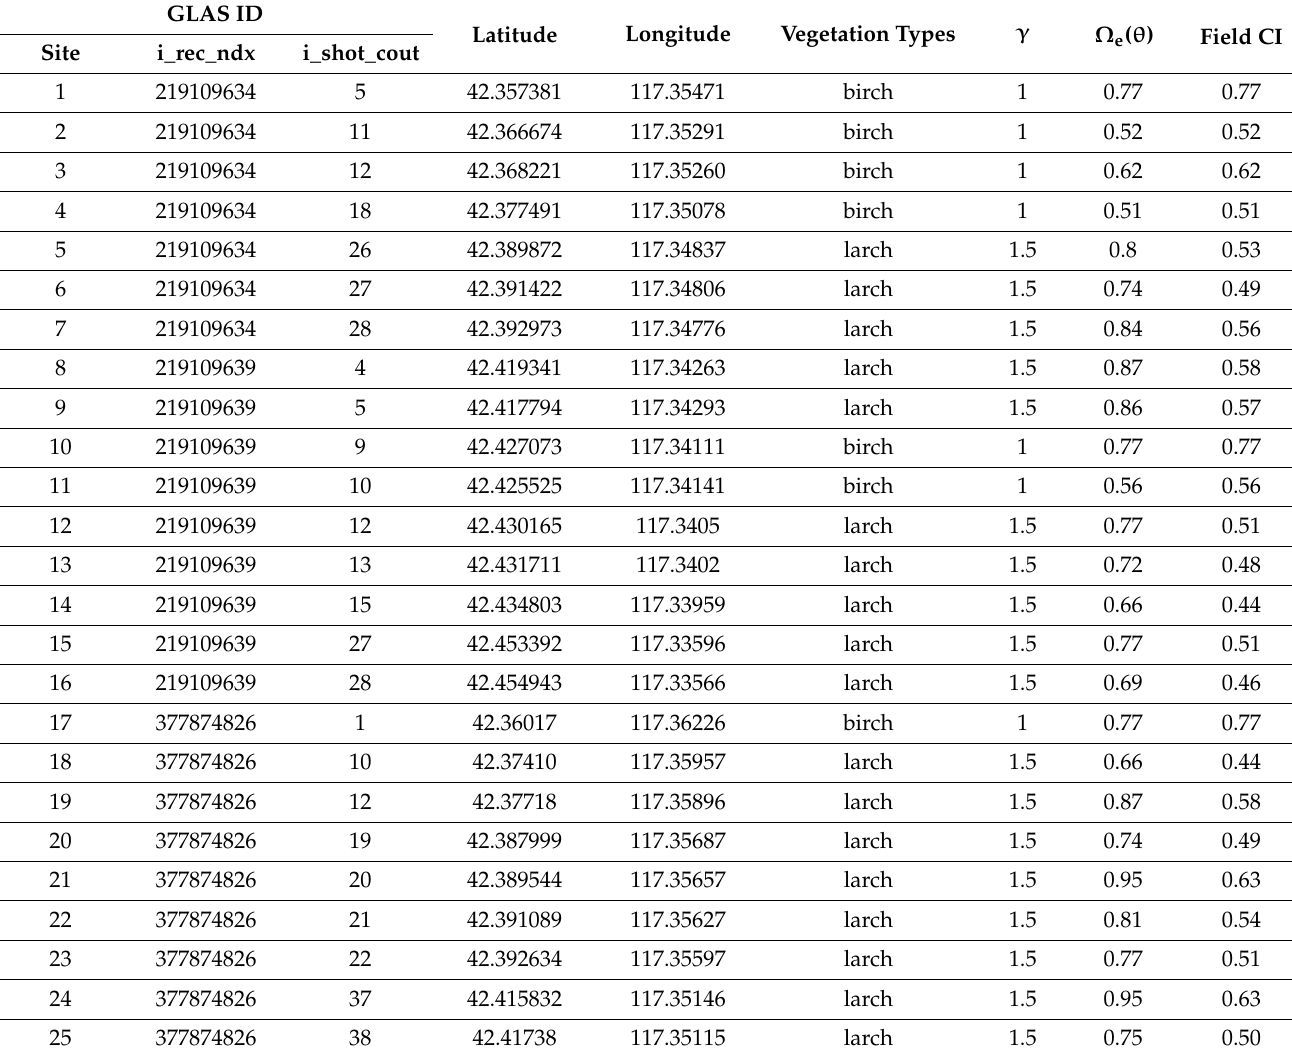
Table A1. Characteristics of 50 validation sites. GLAS ID is the index of GLAS footprint in the product file; vegetation types are from the field investigation; γ is the needle-to-shoot area ratio; and Ω e ( θ ) denotes the clumpiness of foliage elements. GLAS